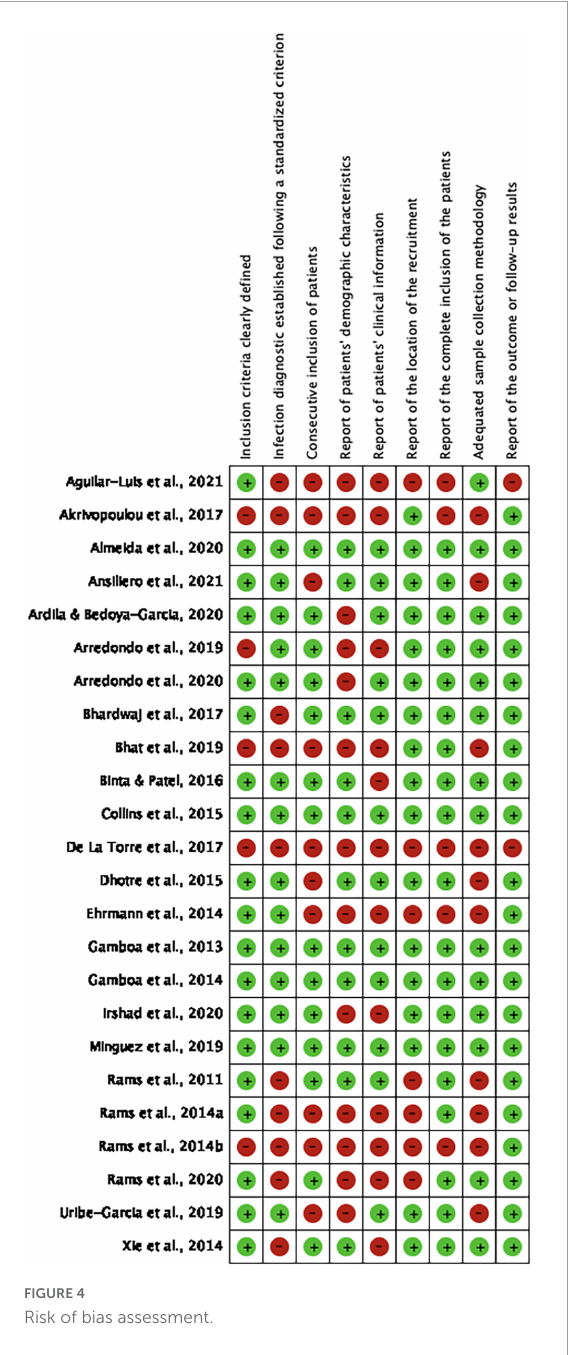
FIGURE4 Risk of bias assessment.